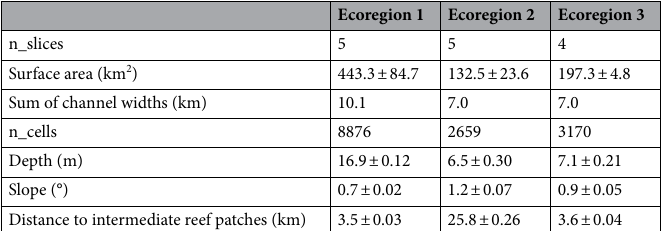
Table 1. Characteristics of the ecoregions (mean ± S.E.M over n slices or over n cells) identified along the New Caledonia western coast